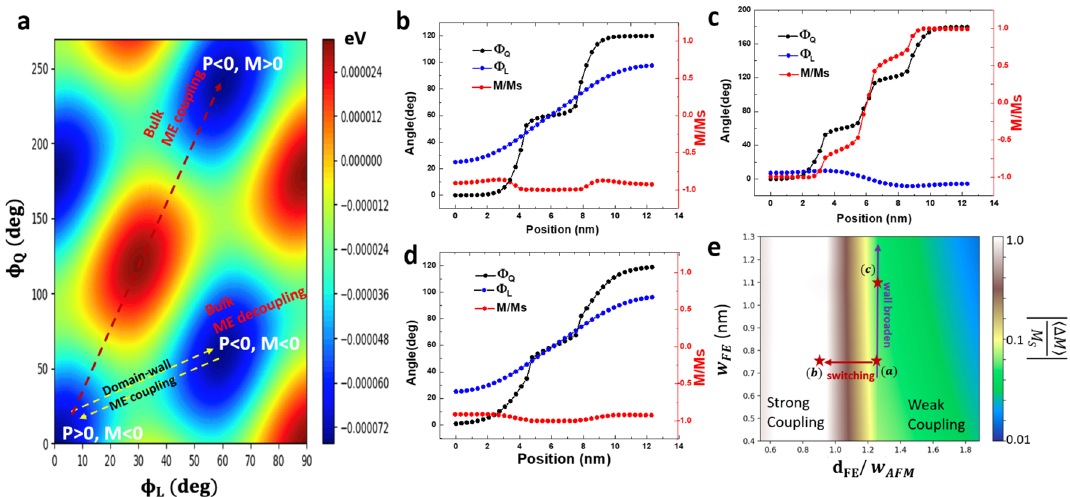
Figure 3. ( a ) Landscape of magnetic free energy of h-YbFeO 3 with φ Q and φ L as independent parameter, with arrows correspond to potential switching paths for ME coupling and decoupling. ( b – d ) The domain-wall ME coupling inside a 12.5 nm grain with multiple FE walls and corresponded profiles of φ Q , φ L and M/Ms. The FE wall width is 0.75 nm in ( b , c ) and 1.1 nm in ( d ). ( e ) Phase diagram of averaged reduction of magnetization due to domain-wall ME coupling, with respect to w FE and d FE /w AFM , the red and purple arrows represent polarization switching and FE wall broadening in h-YbFeO 3